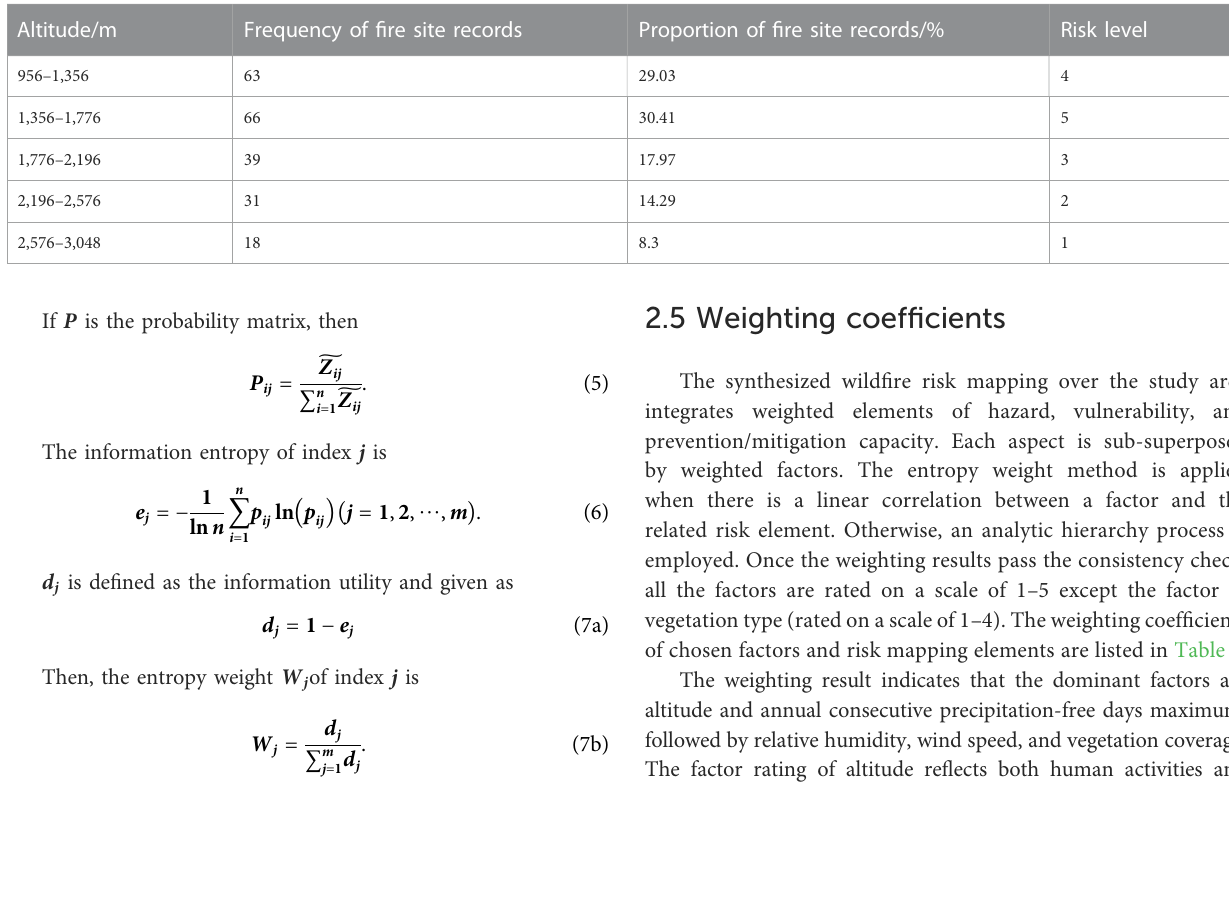
TABLE 2 Classi fi cations of